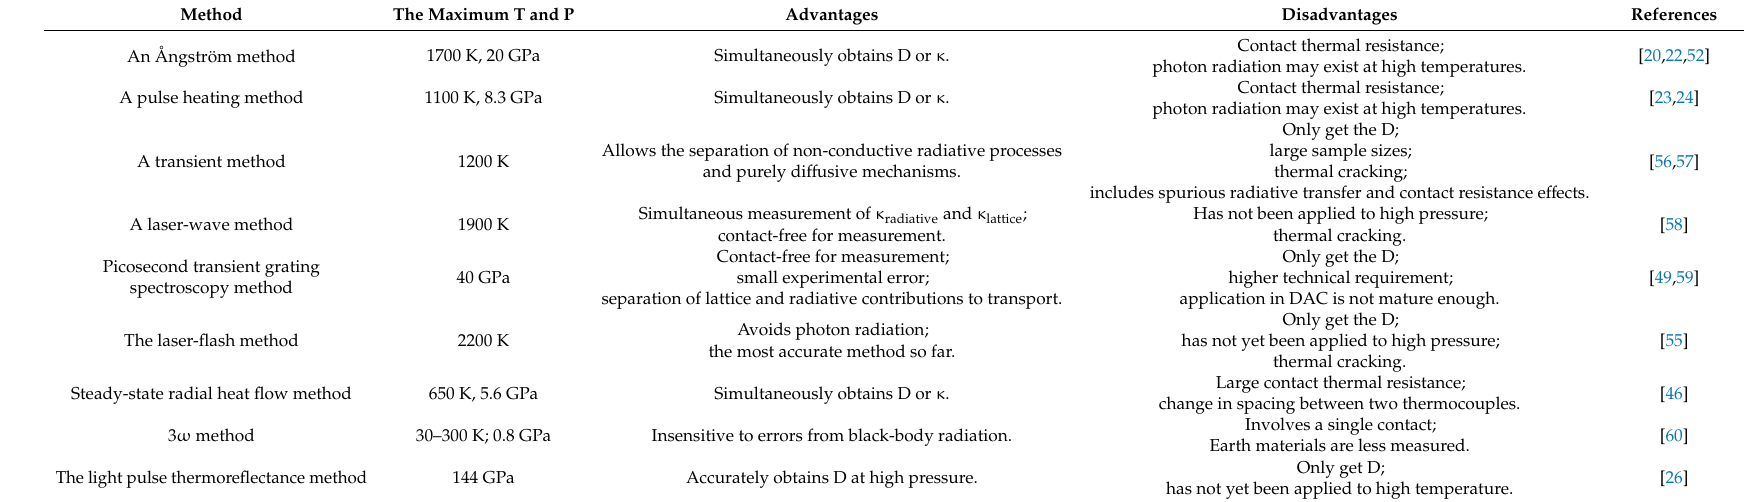
Table 1. The scope of application of major measurement